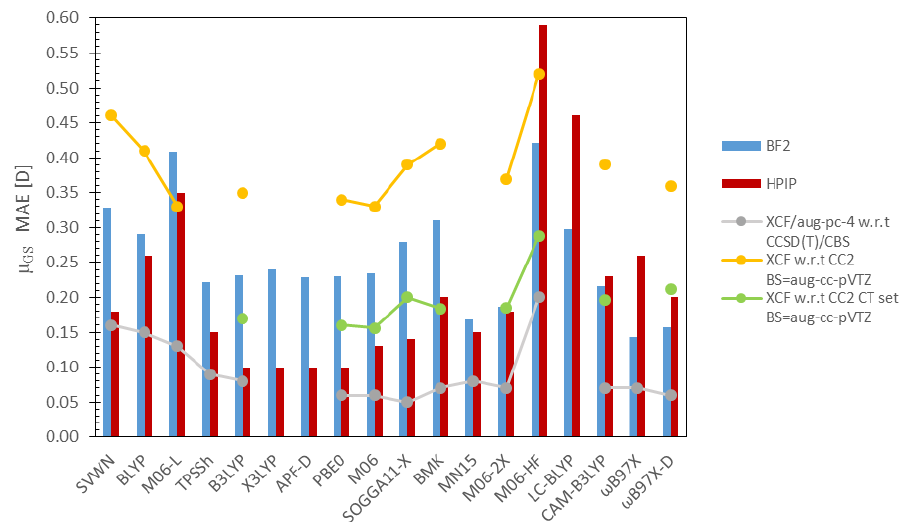
Figure 5. Comparison of DFAs predictive power; data presented in columns concern µ GS calculated in this work, while information displayed as “lines” relate to literature data—grey, the database of 200 dipole moments of small inorganic molecules developed by Gordon and Hait [143]; yellow, a set of 15 small organic molecules; and green, 15 large organic molecules exhibiting CT